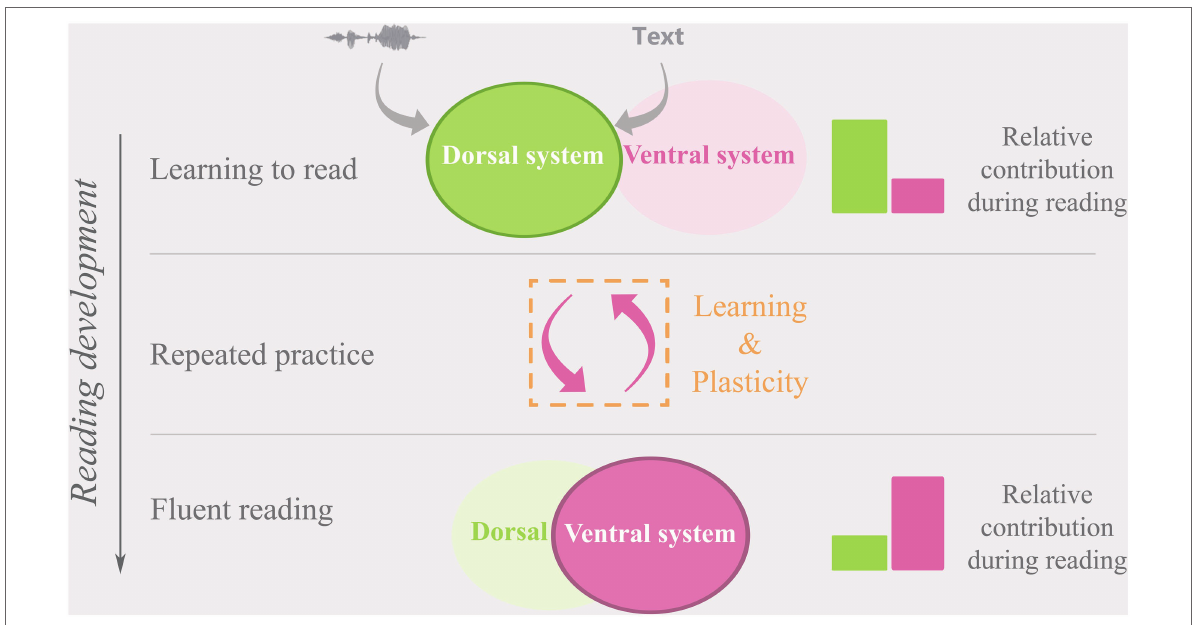
FIGURE 3 | A representation of the relative dorsal (green) and ventral (pink) cortical reading network contribution over the course of reading